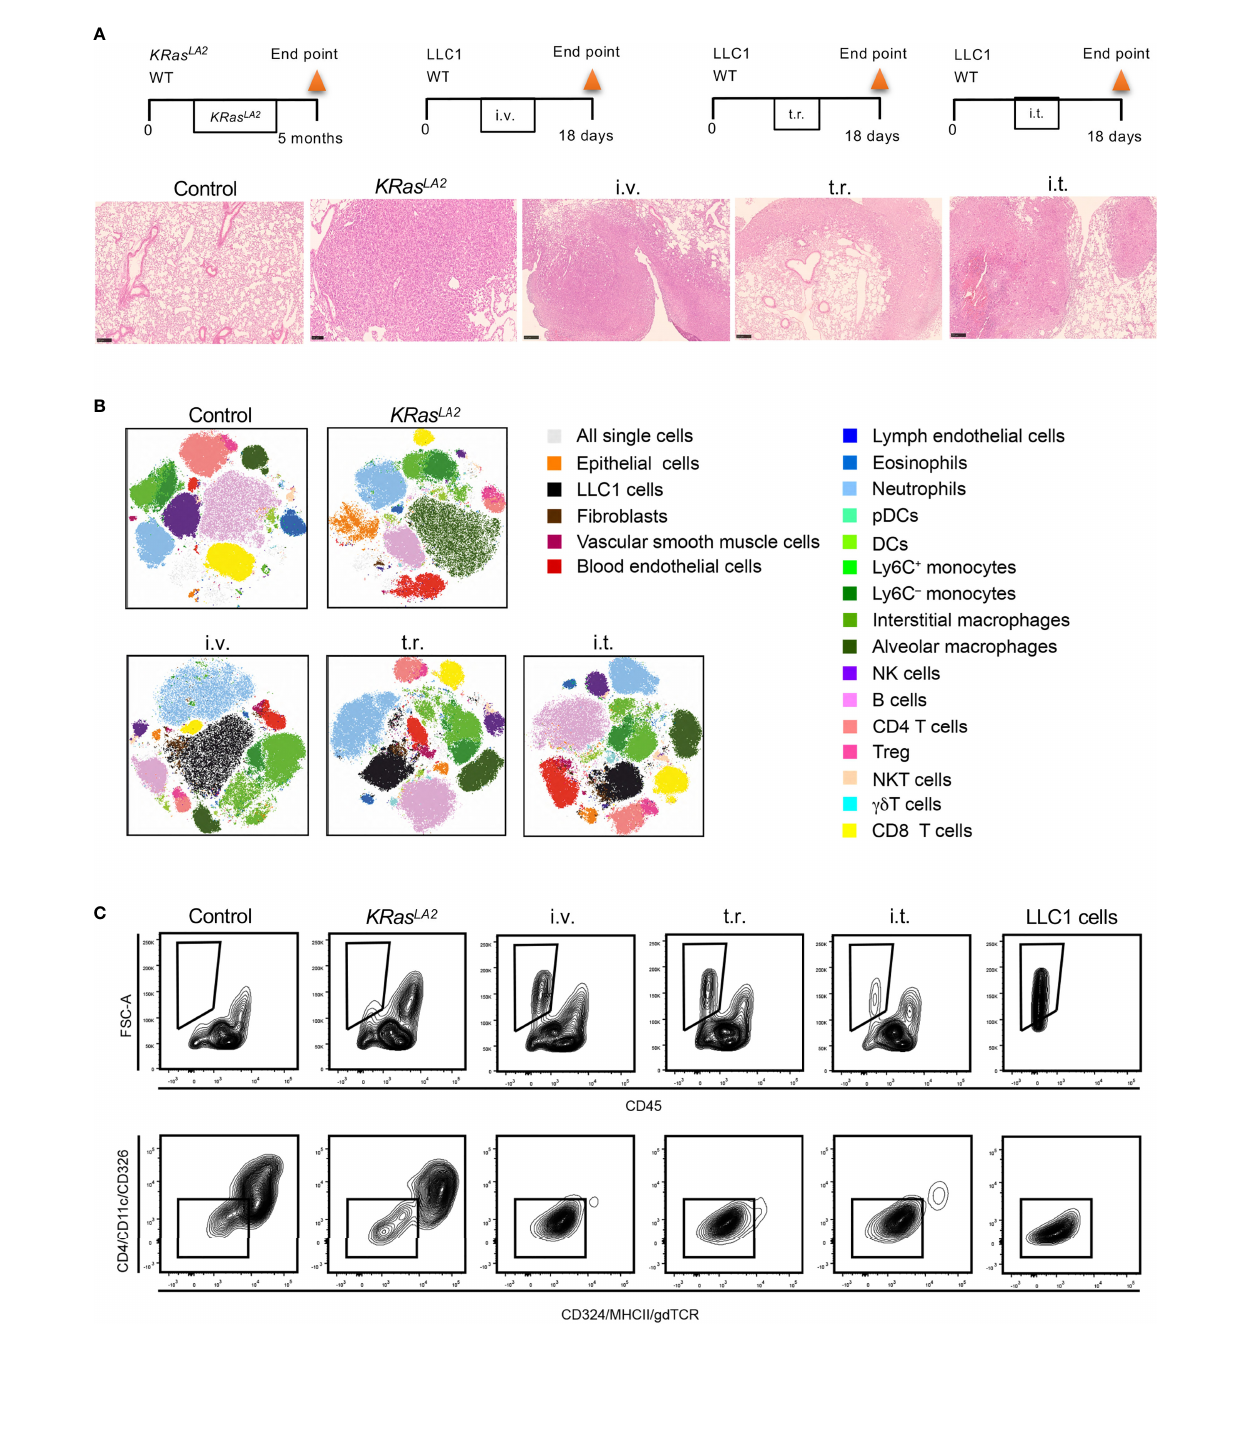
FIGURE 4 | Cell composition in different murine lung cancer models. (A) Schematic representation of primary and metastatic lung tumor